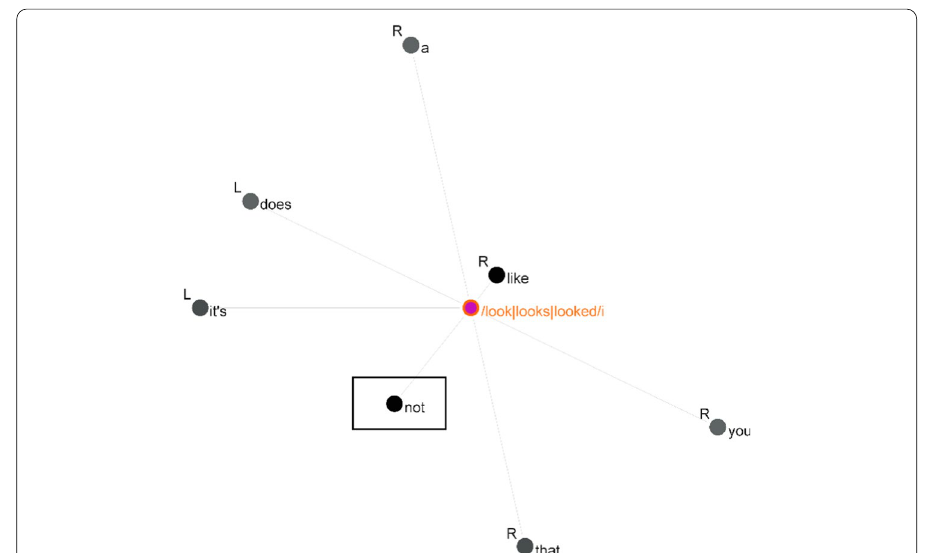
Fig. 2 Collocation network: look|looks|looked in Easson Corpus of Transferred Negation (06—LogLik (6.63), L5-R5, C: 3.0-NC: 3.0; no filter